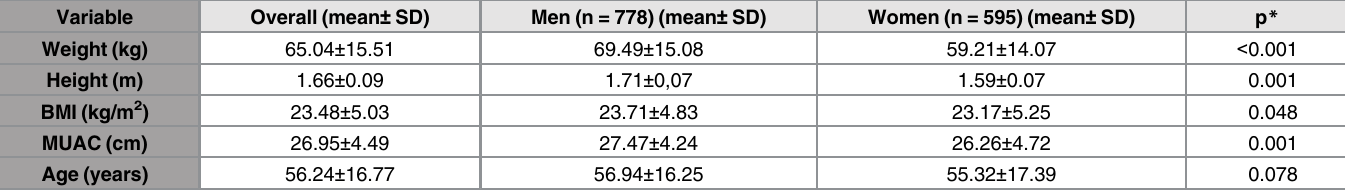
Table 1. Anthropometric characteristics of the sample.